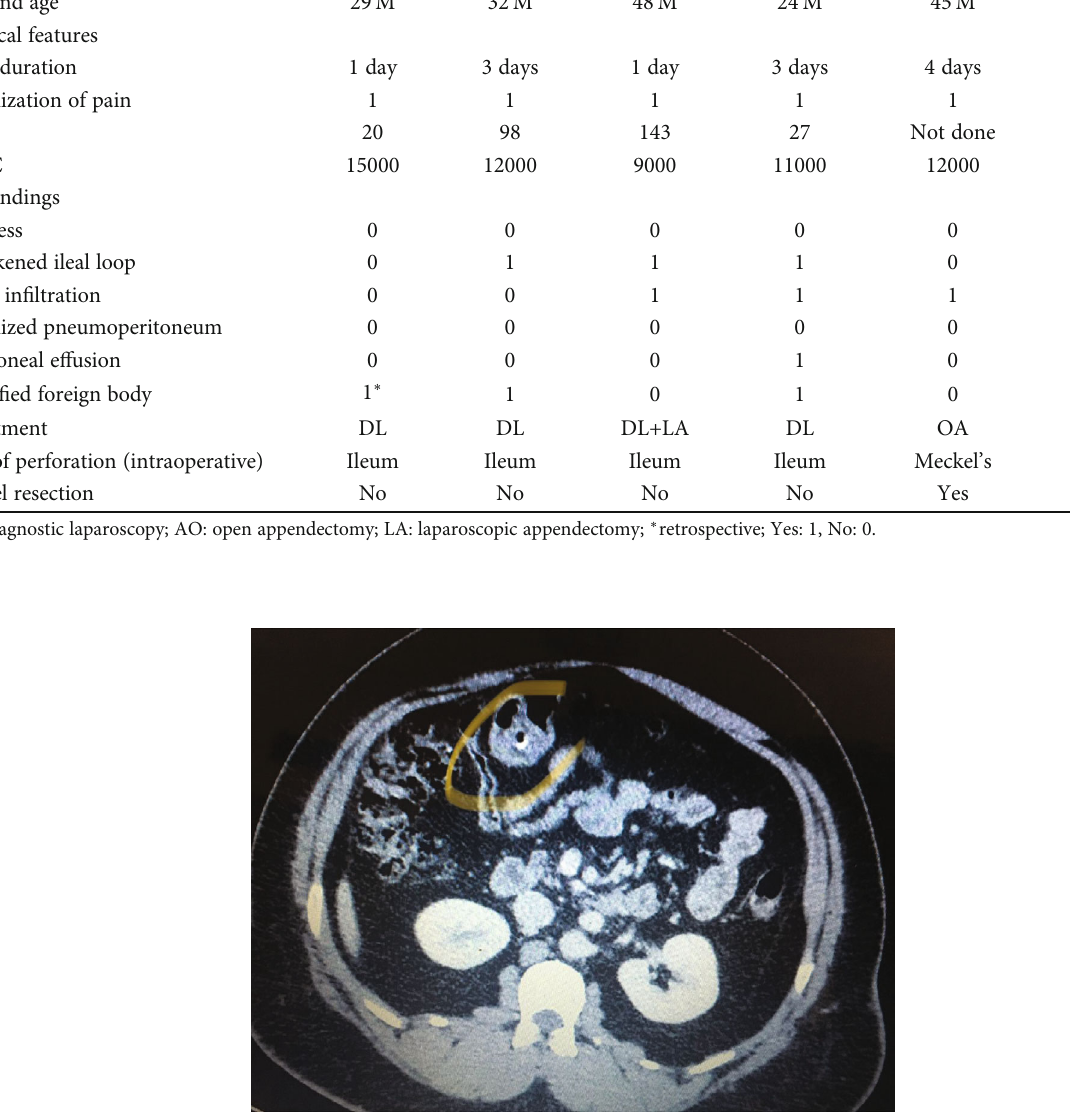
Figure 1: CT scan of case number